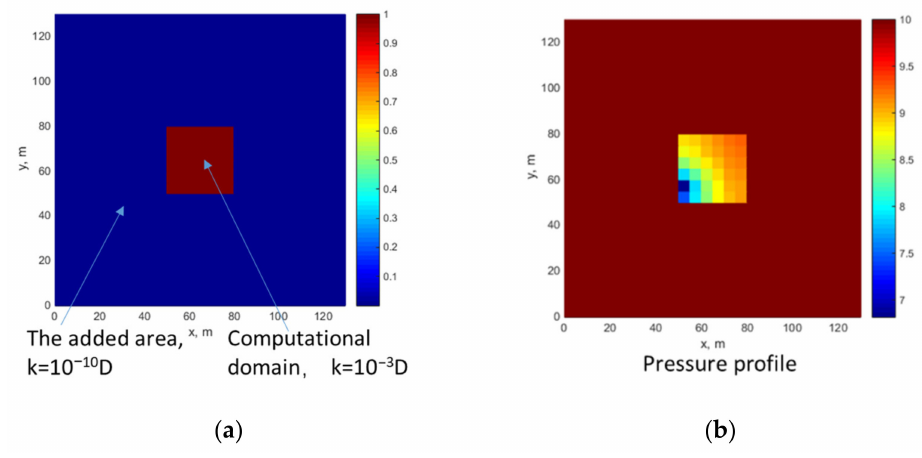
Figure 1. Sketches of boundary treatment. ( a ) Permeability profile; ( b ) pressure